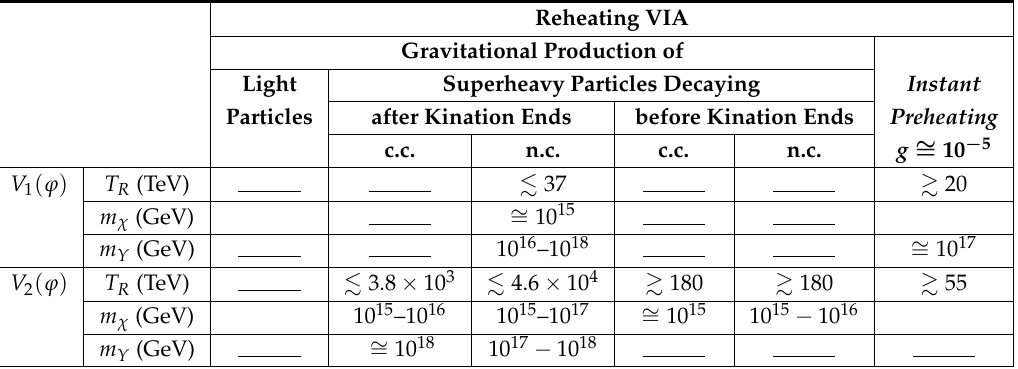
Table 1. Constraints for T R , m χ and m Y for the different potentials and reheating mechanisms. Reheating VIA Gravitational Production of Light Superheavy Particles Decaying Instant Particles after Kination Ends before Kination Ends